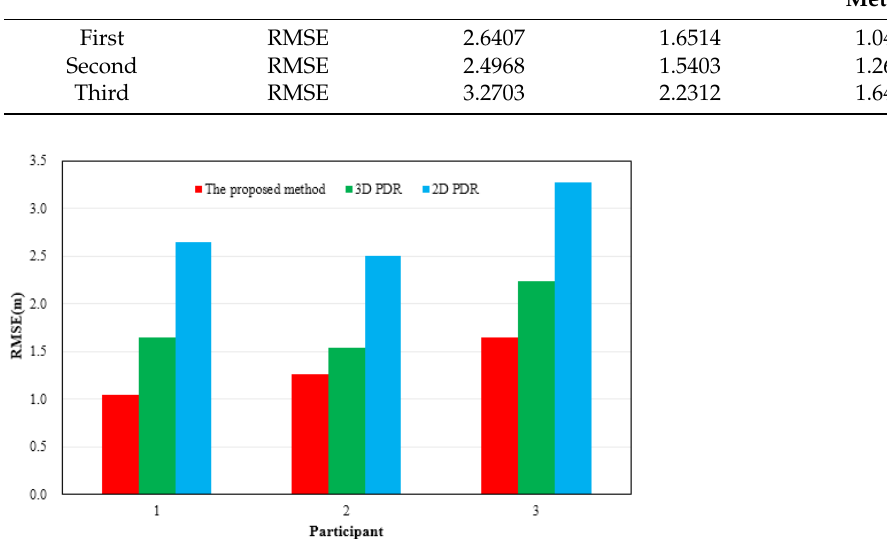
Figure 7. Distributions of the RMSE of location results in location tracking for three